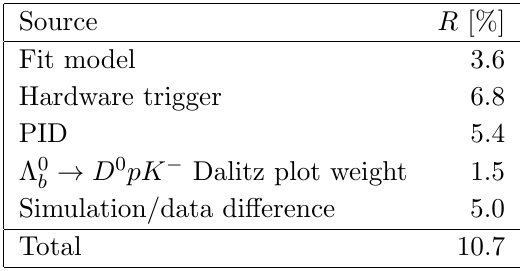
Figure 4 . E(cid:14)ciency of selected (cid:4) 0 ! D 0 pK (cid:0) decays as a function of the invariant masses m ( D 0 p ) bc and m ( pK (cid:0) ) in the simulation. The variation of e(cid:14)ciency across the Dalitz plot re(cid:13)ects the speci(cid:12)c phase-space dependent requirements of the selection.